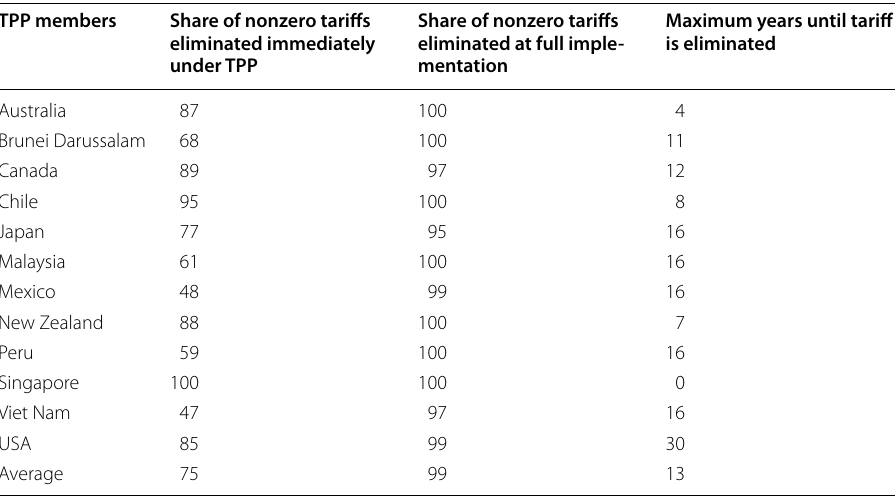
Table 2 Proposed tariff elimination under TPP by the members. Source : TPP tariff sched- ules, http://ustr.gov/trade-agreements/free-trade-agreements/trans-pacific-partnership/